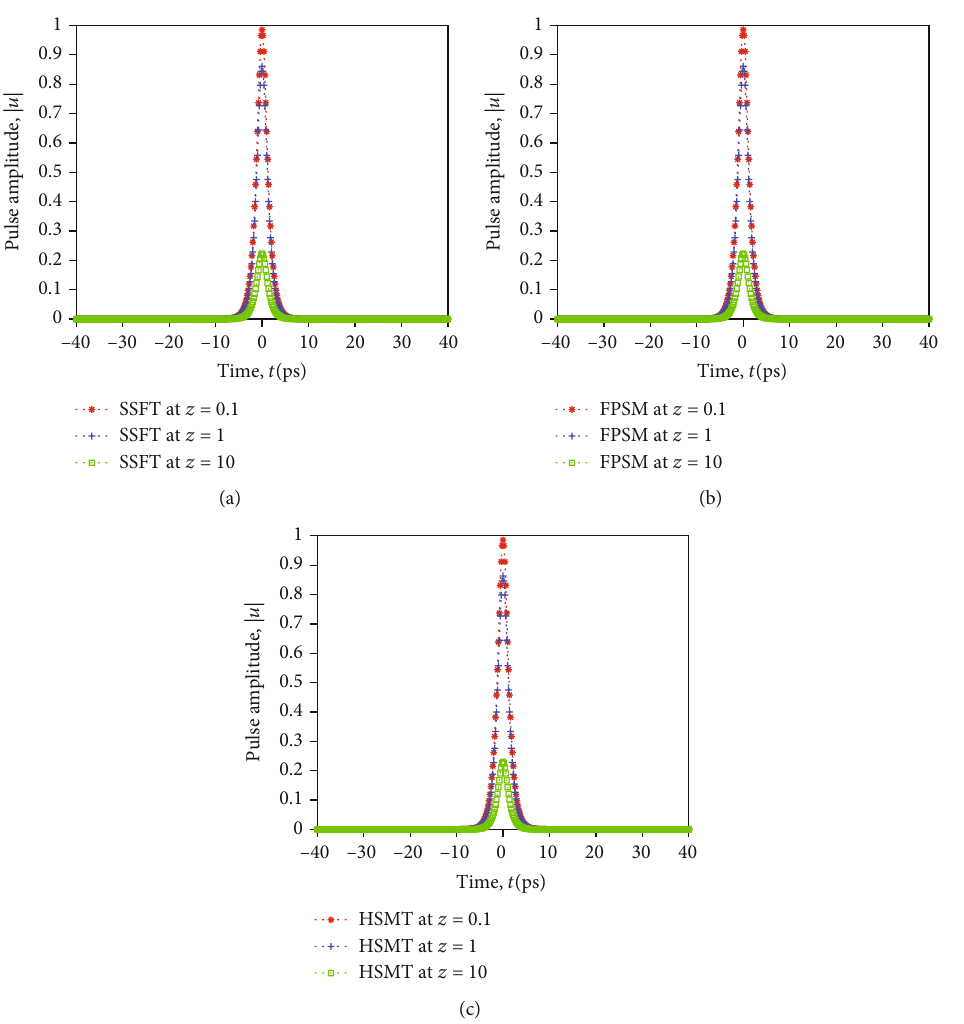
Figure 6: A comparison of the split-step Fourier transform (SSFT) (a), the Fourier pseudospectral method (FPSM) (b), and the Hopscotch method (HSM) (c) approximate solutions at for a lossy optical fi ber α = 0 : 3 dB/km when the input pulse is a bright soliton at distances z = 0 : 1, 1, 10 km,